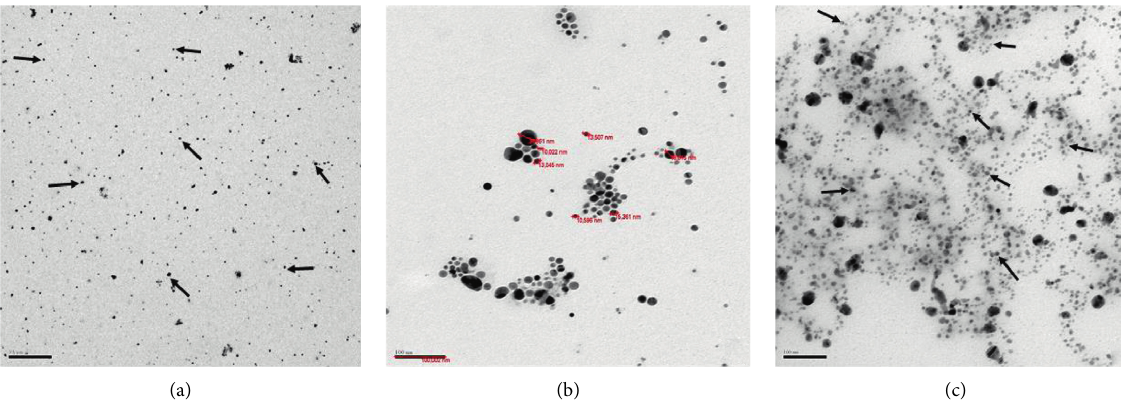
Figure 2: TEM micrograph of AgF solution immediately after manufacture; (a) predominantly spherical silver nanoparticles (arrow) dispersed in the colloidal solution; (b) higher magnification allows verifying the sizes of 7–30nm of silver nanoparticles; (c) micrograph of solution 12 months after manufacture. The silver nanoparticles (arrow) remained dispersed in the solution after approximately 12 months of preparation (image with 100nm scale). Table 1: Median inhibition zone description (mm) of SDF, CHX, AgF, and Ag. Treatment